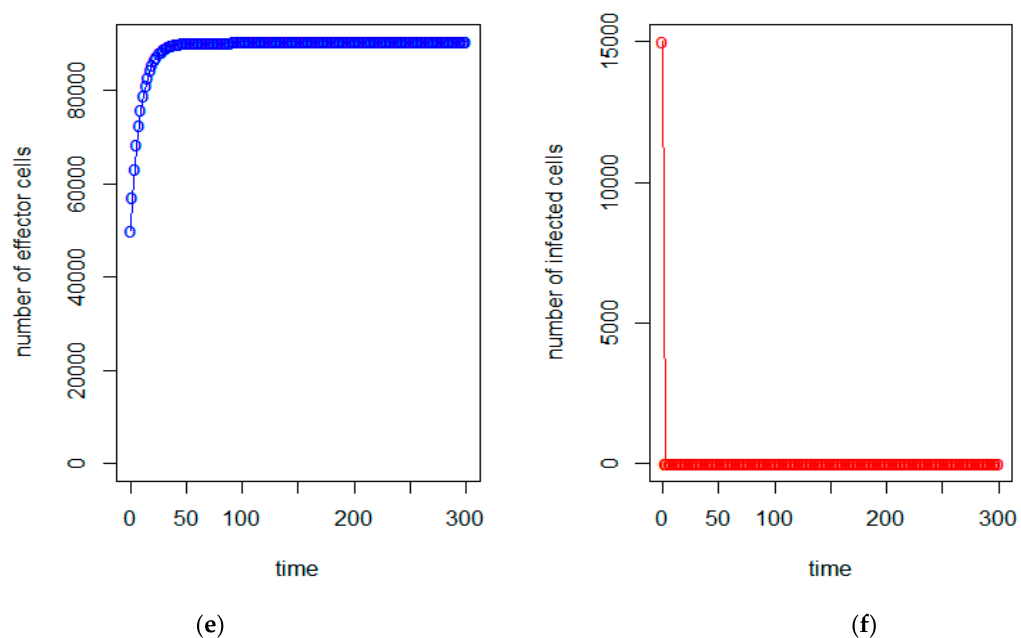
Figure 5. ( a , b ): The immune-effector cells ( a ) and virus-infected cells ( b ) vs. time (days); ( c , d ):When the initial number of immune-effector cells I 0 = 75,000 cells. The immune-effector cells ( c ) and virus-infected cells ( d ) vs. time (days); ( e , f ): When the initial number of virus-infected cells V 0 = 15,000 cells. The immune-effector cells ( e ) and virus-infected cells ( f ) vs. time (days).